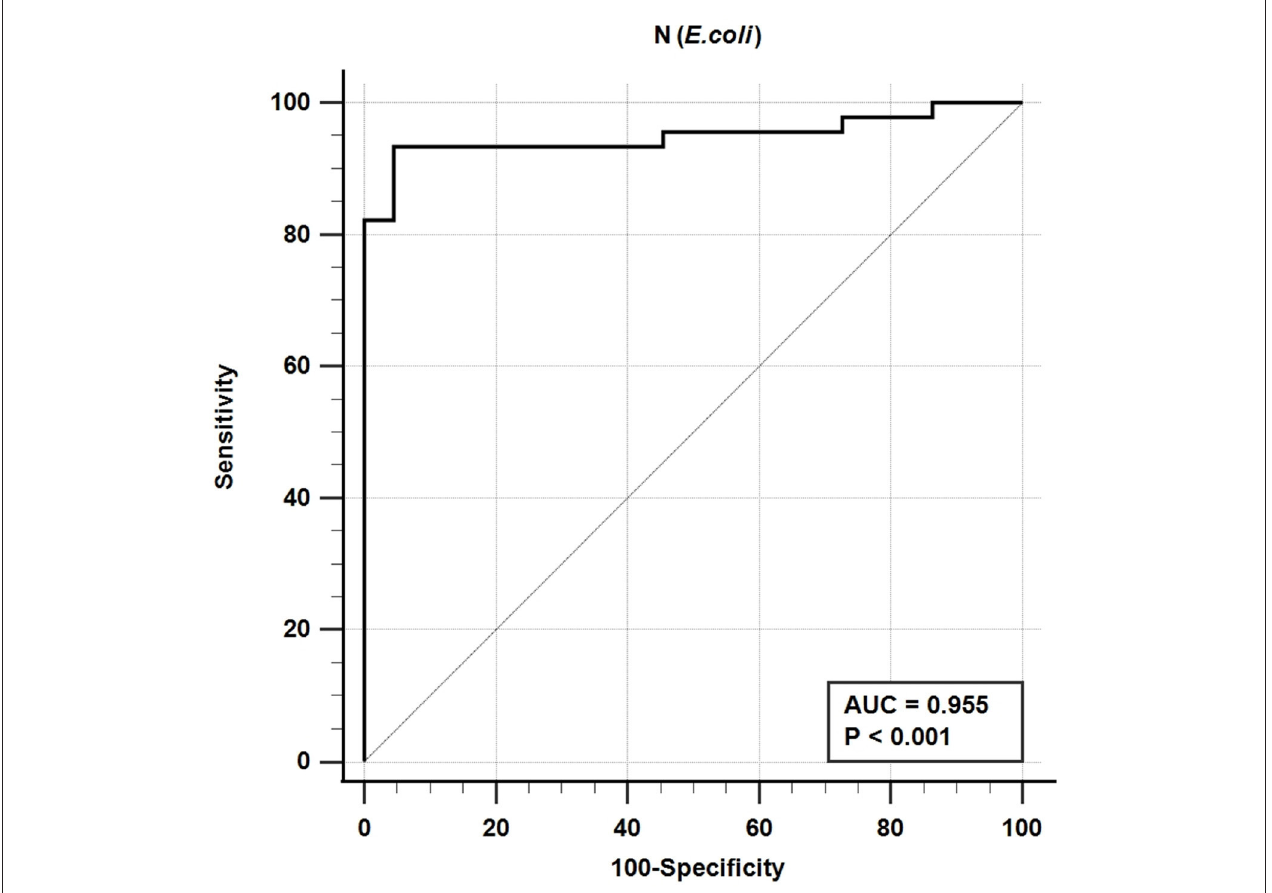
FIGURE 1 | Receiver-operating characteristic (ROC) analysis for the N E protein iELISA. The line represents the 95% confidence interval, and the upper left corner is the highest Youden index indicating the best combined sensitivity and specificity of 93.3% and 95.5%, respectively. AUC, area under the curve.